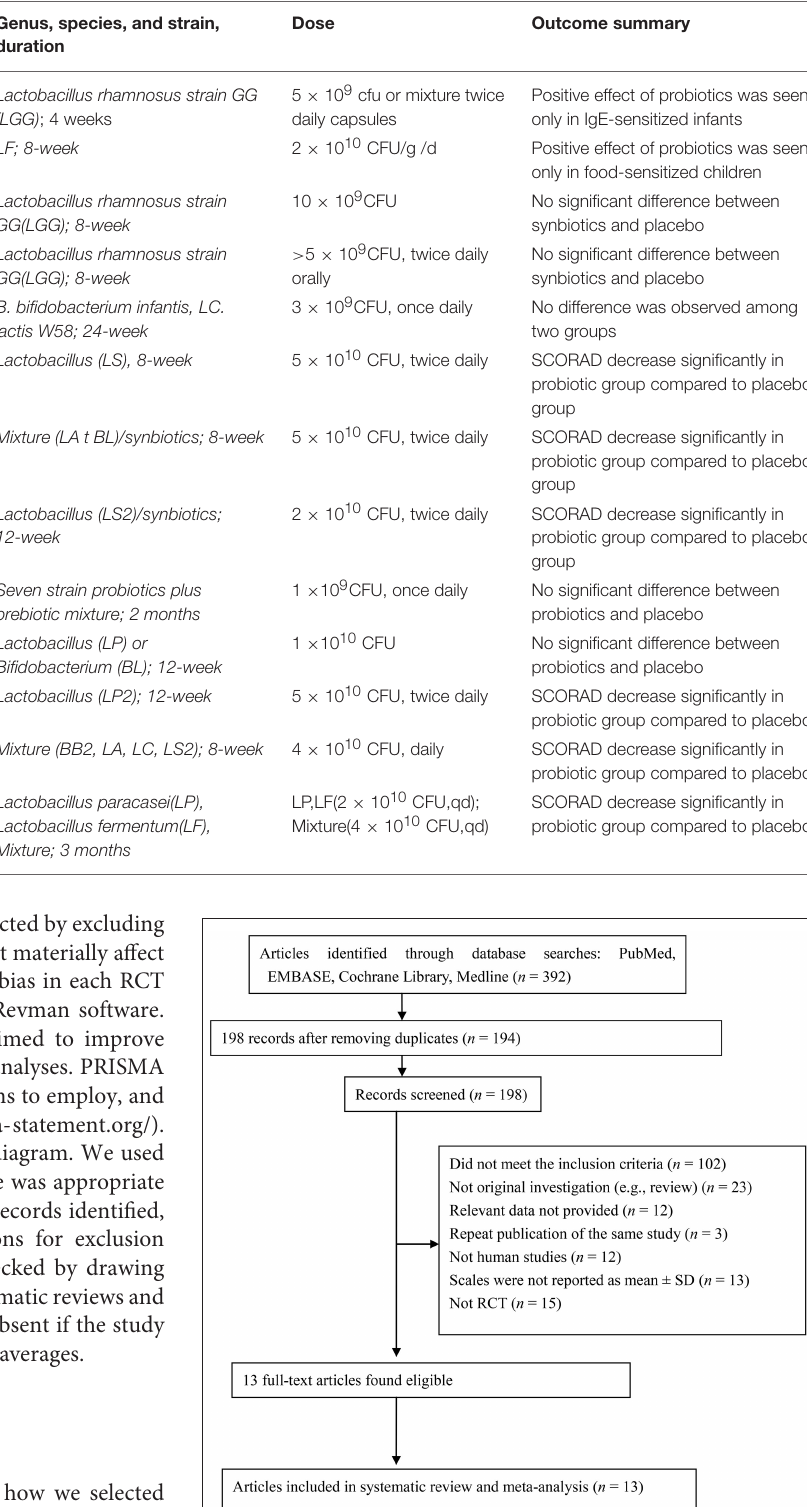
TABLE 1 | Characteristics of included RCTs for meta-analysis.